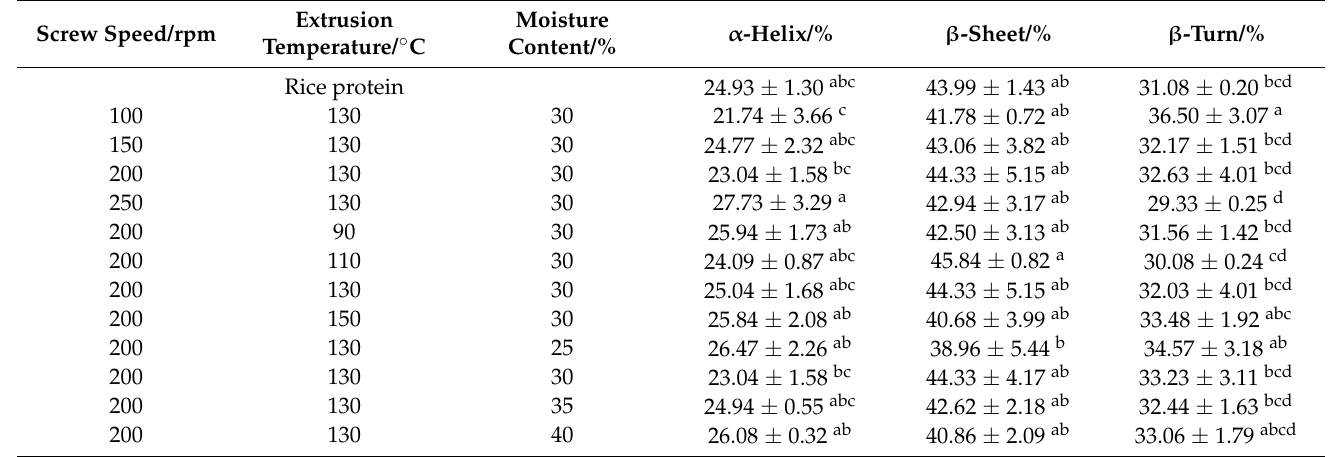
Table 6. Protein secondary structure of TRP under different extrusion